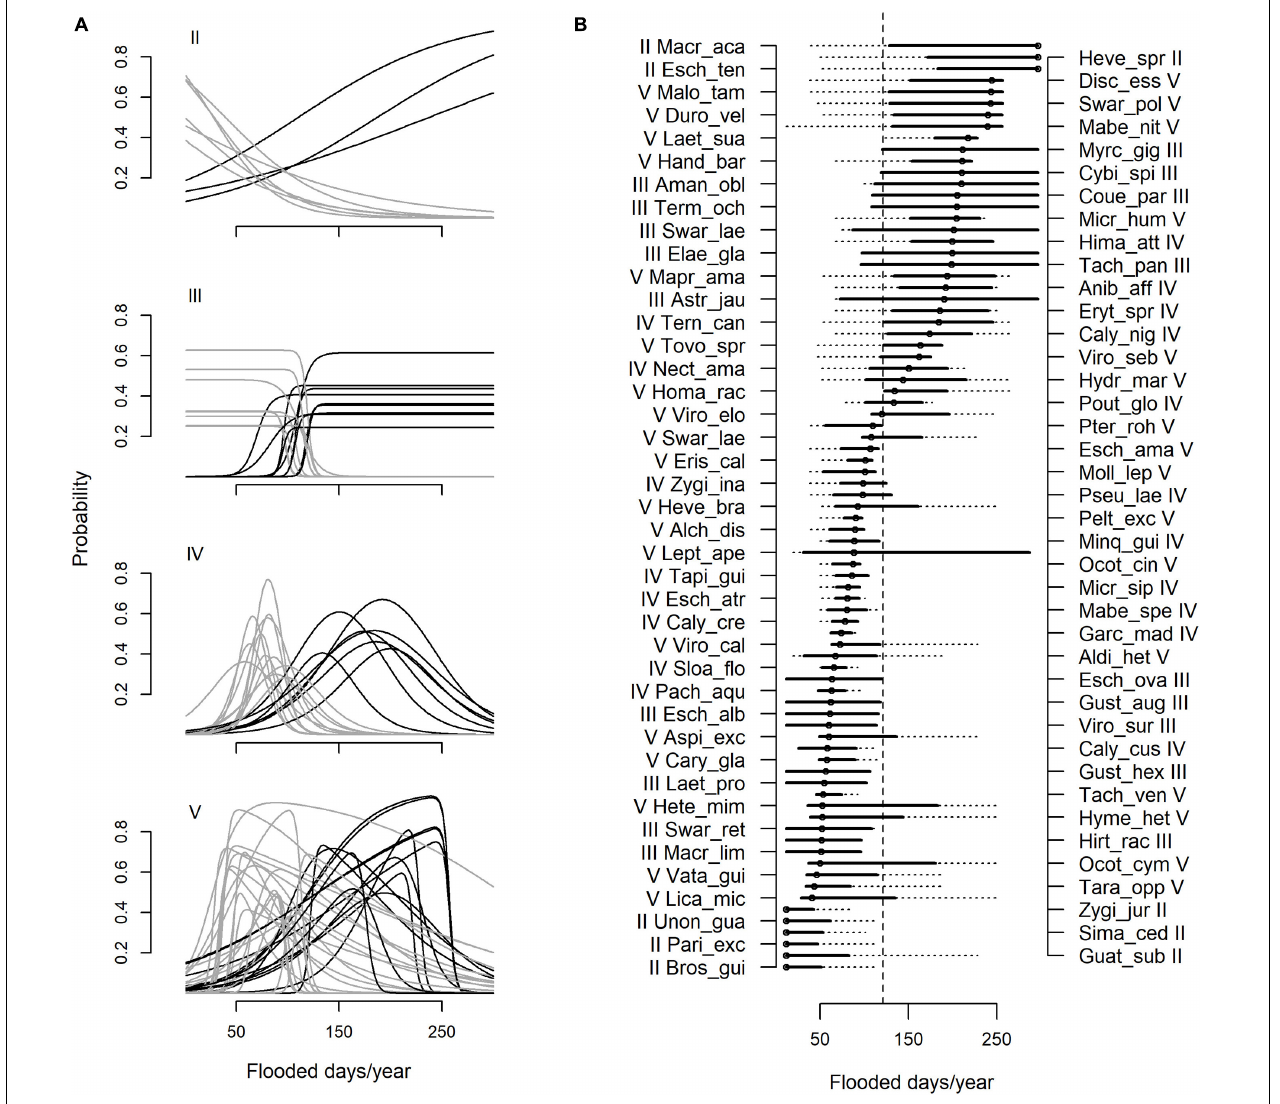
FIGURE 2 | Modeled response curves (A) and niche properties (B) of 81 floodplain species along the flood duration gradient. The responses of an additional 30 species were more consistent with a flat model (Model I) and not shown. (A) Roman numerals indicate the most appropriate HOF model, selected according to the Akaike Information Criterion and a parallel bootstrap approach to account for sensitivity of model choice for poorly sampled species. Huisman–Olff–Fresco models (eHOF): (II) monotonic sigmoid (III) sigmoid with plateau, (IV) unimodal symmetric, and (V) unimodal skewed. Species have been categorized into those favored by severe flooding > 120 flooded days year − 1 (black curves), and those favored by weak flooding, with optima less than 120 flooded days year − 1 . (B) Genus and species epithets are abbreviated (see Supplementary Table 2 for full names), with roman numerals indicating the best fitting response shape. Species optima (open circles) are estimated as the flood duration value where the species response is highest. Realized niches, or tolerance (solid horizontal lines) were estimated at where the response reaches exp − 0 . 5 of the highest estimated response value. Broken horizontal lines show the full range of flood duration for species, between at the maximum and minimum flood duration values where species occurred. A vertical broken line at 120 flooded days year − 1 marks the mean optimal value of all